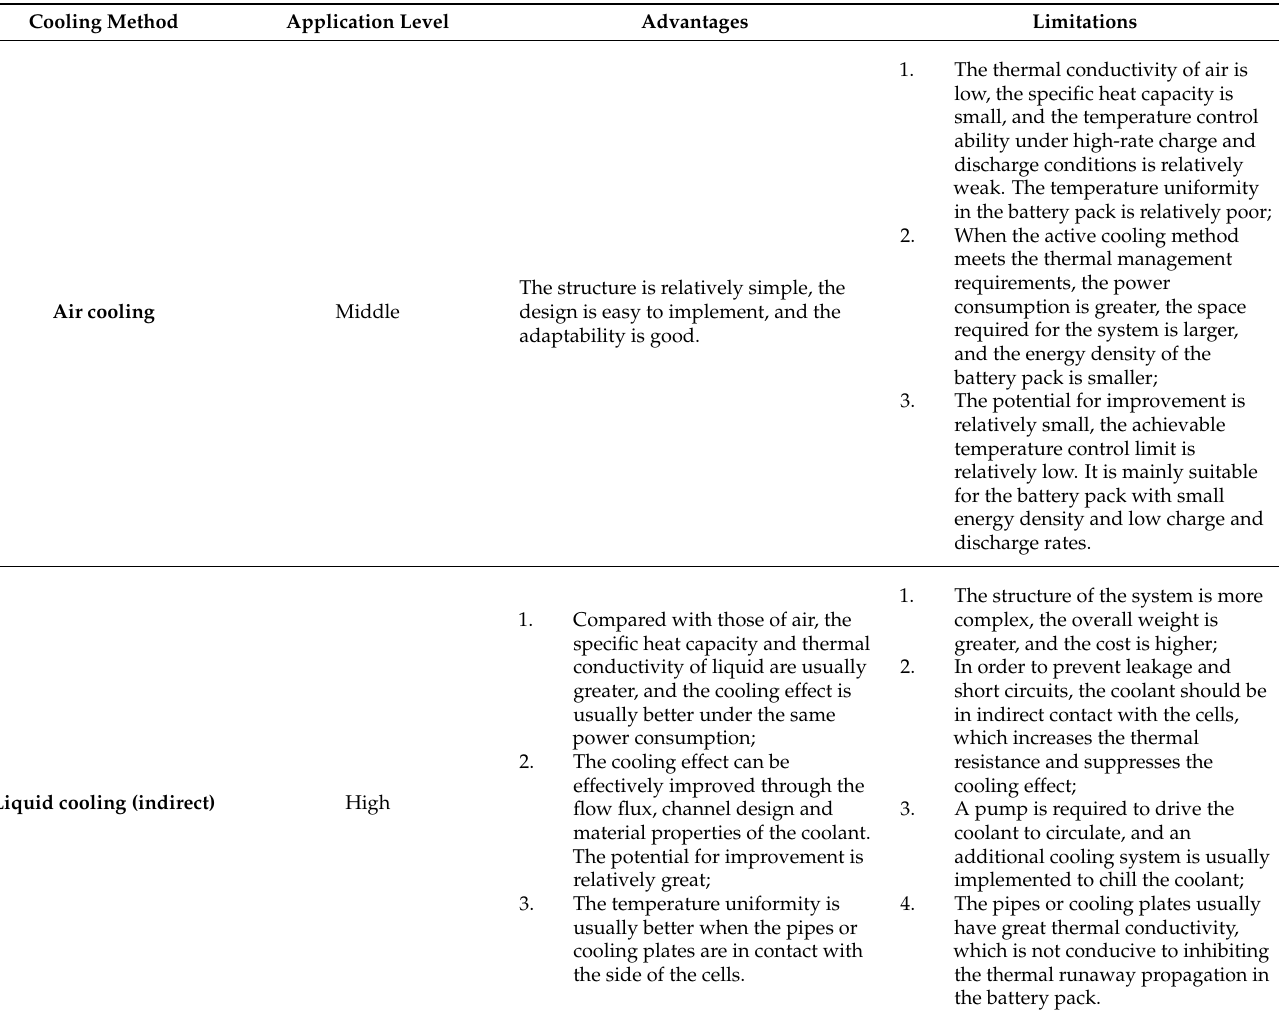
Table 1. Existing BTMS